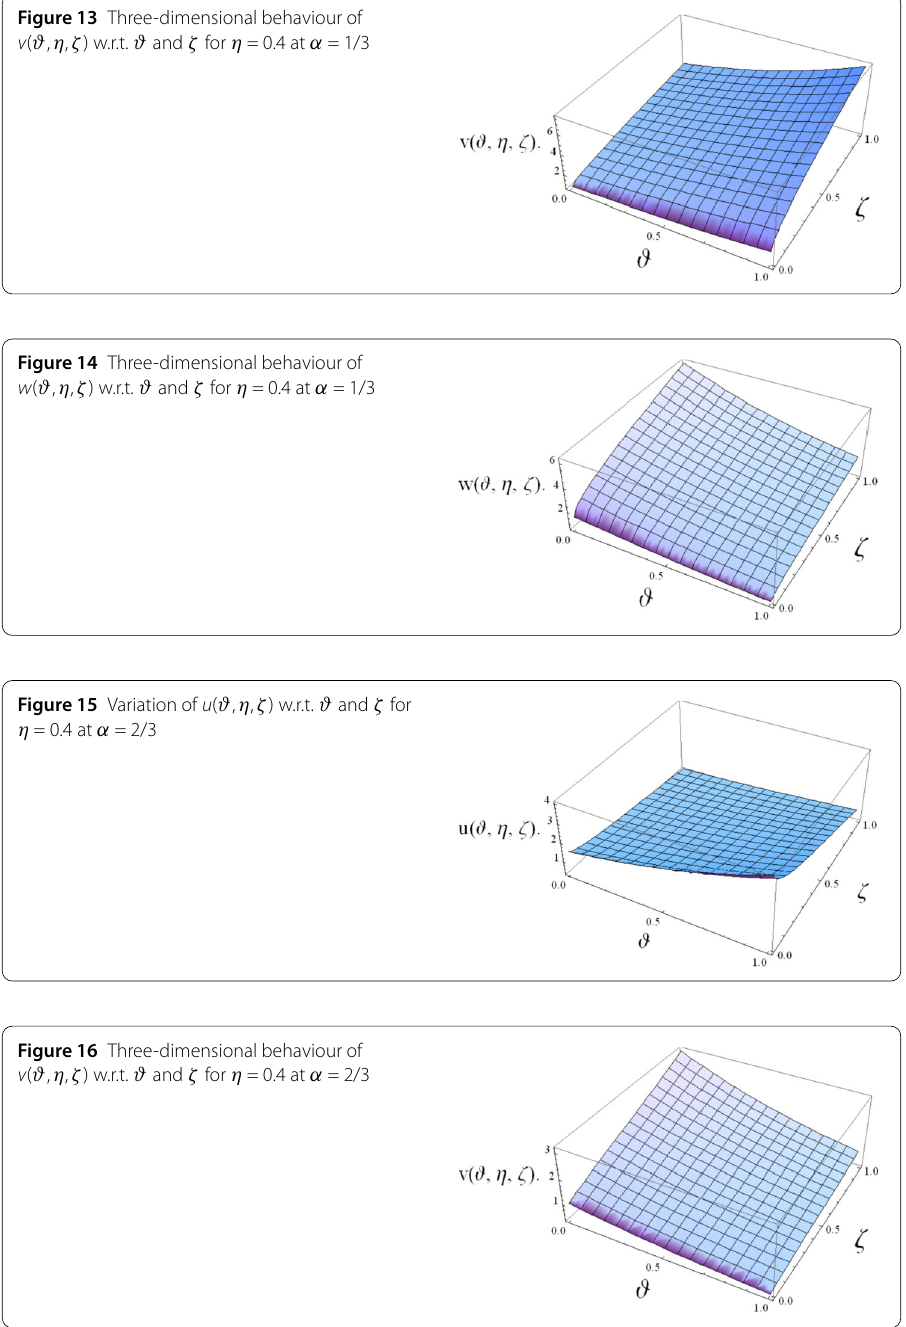
Figure 13 Three-dimensional behaviour of v ( ϑ , η , ζ ) w.r.t. ϑ and ζ for η = 0.4 at α = 1/3